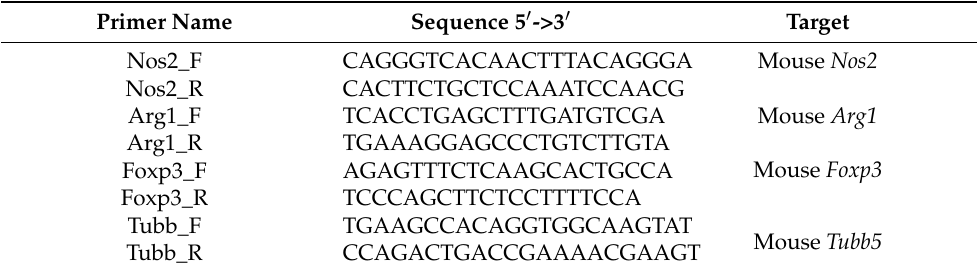
Table 1. Primers used for the